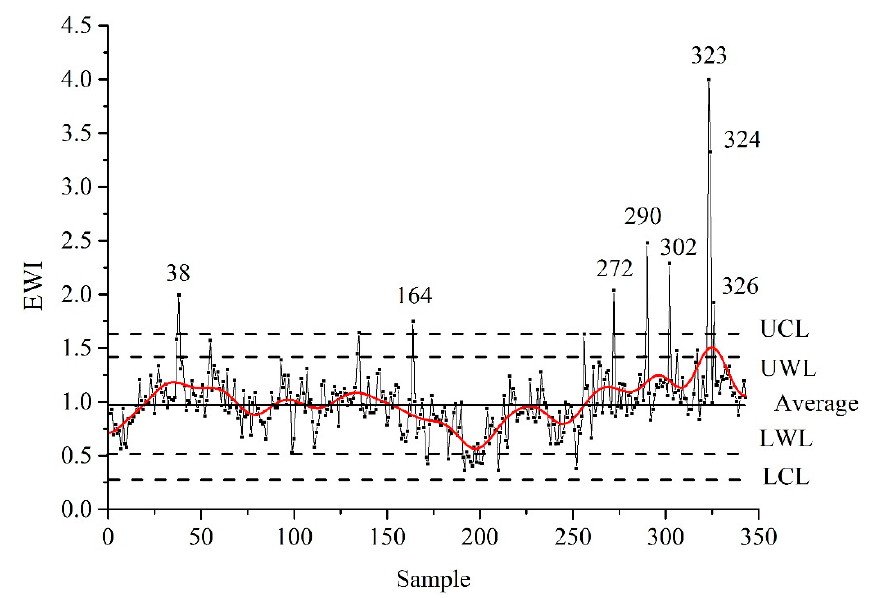
Figure 2. Entropy weighted index (EWI) plot of wastewaters during year. The labels identify the samples.